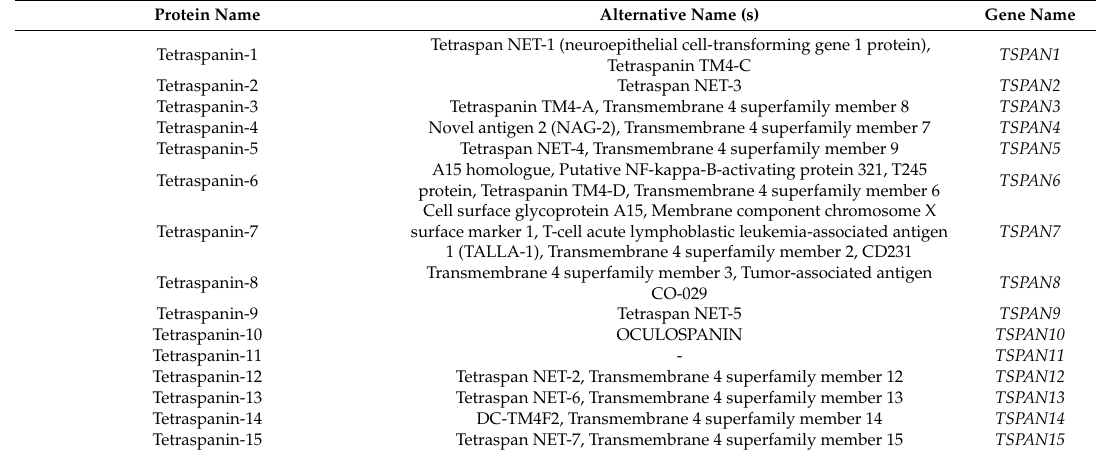
Table 1. List of human tetraspanin superfamily members. Data were acquired from the UniProt database (UniProt Consortium. (2019). UniProt: A worldwide hub of protein knowledge. Nucleic acids research, 47(D1),